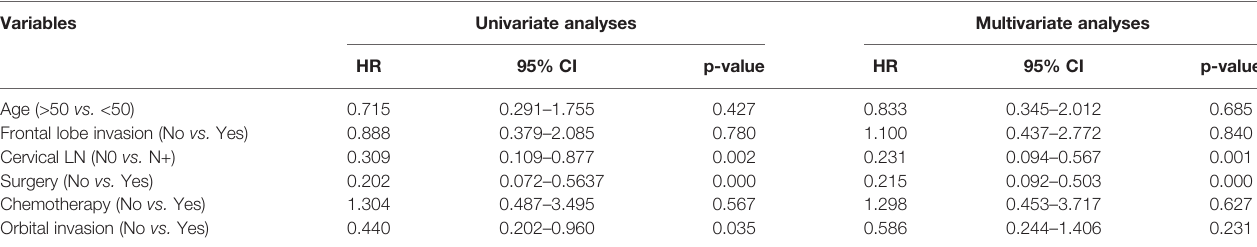
TABLE 2 | Univariate and multivariate analyses of factors in relation to overall survival using the cox proportional hazards model (n = 111). Variables Univariate analyses Multivariate analyses HR 95% CI p-value HR 95% CI p-value Age (>50 vs.